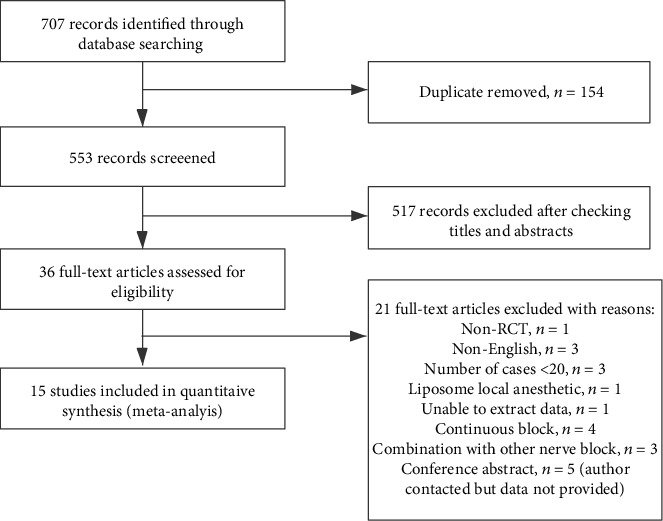
Flowchart of the literature search for the included studies.